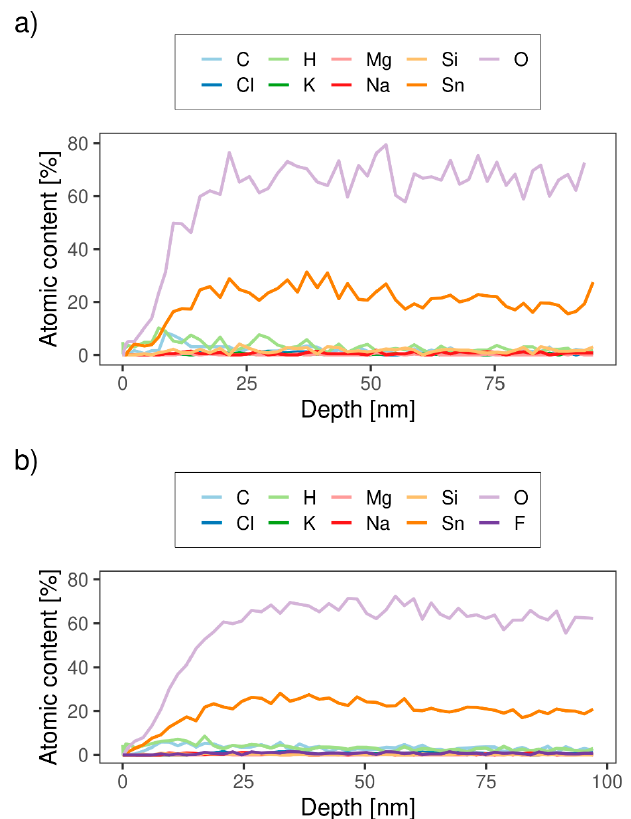
Figure 4. TOF-ERDA elemental depth profile calculated by Potku (slab analysis) for SnO 2 samples: ( a ) S-590 and ( b ) B-590.